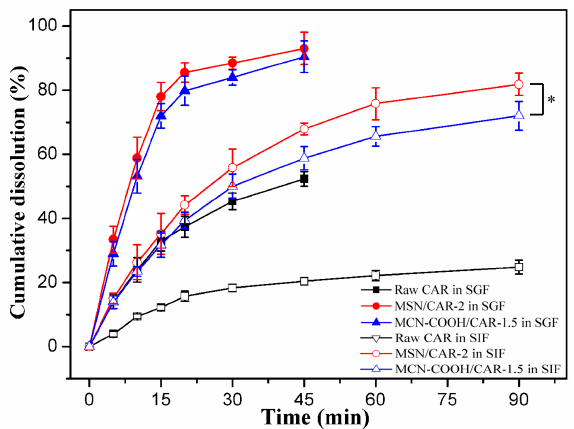
Figure 7. In vitro dissolution profiles of raw CAR, MSN/CAR–2 and MCN–COOH/CAR–1.5 in SGF and SIF. (The * represents significant difference, p < 0.05).